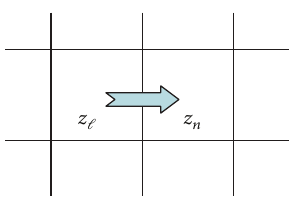
Figure 2: Movement of occupants from zone 𝑧 ℓ to the adjacent unoccupied zone 𝑧 𝑛